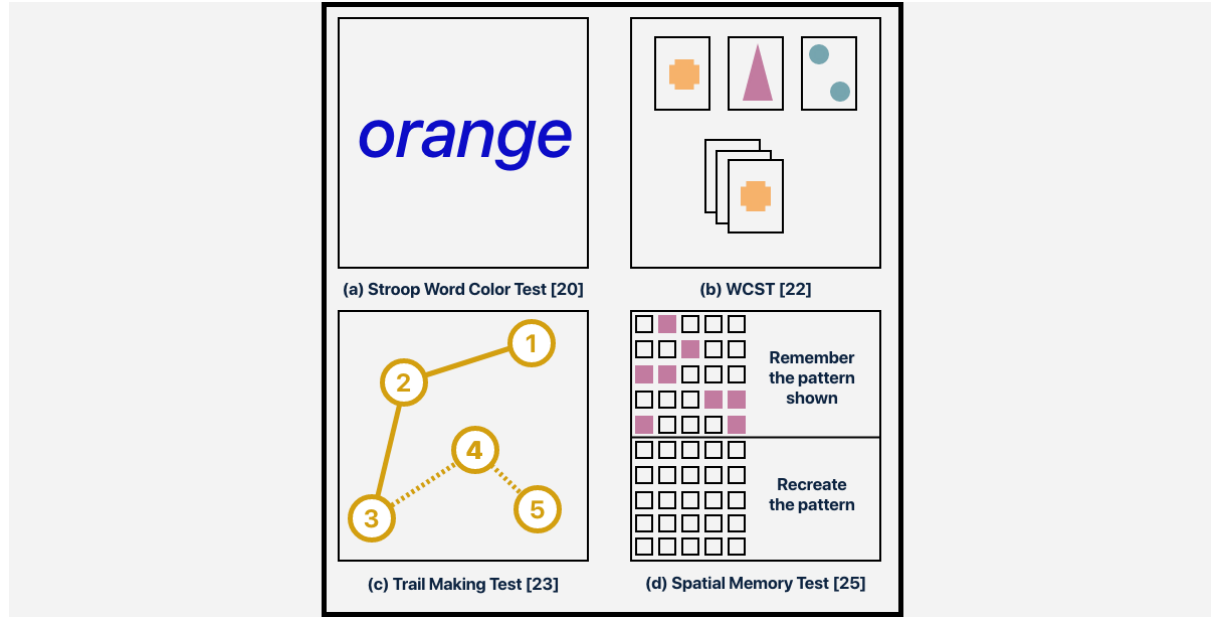
Figure 3. A sample view set of functional tests. WCST: Wisconsin Card Sorting Test.